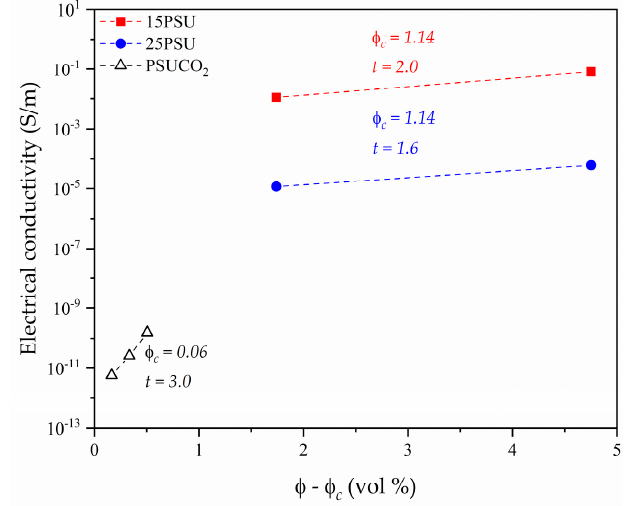
Figure 4. Evolution of the electrical conductivity of PSU–GnP nanocomposites with φ – φ percolation fitting curves and the values of the percolation threshold and the percolation exponent.